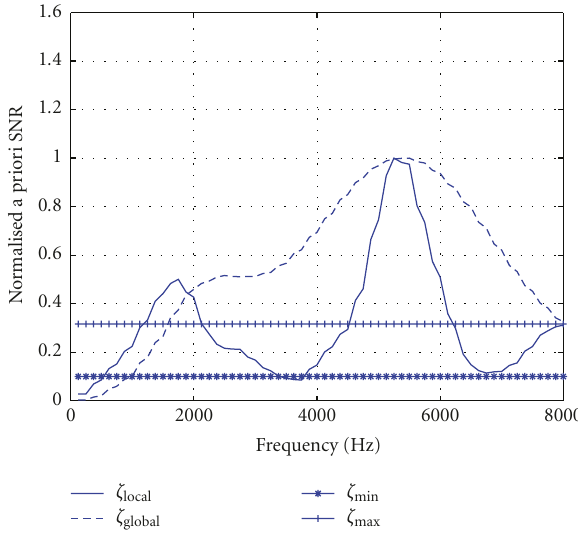
Figure 4: Local and global averaging of the a priori SNR for a given frame. Example of a high a priori SNR at high